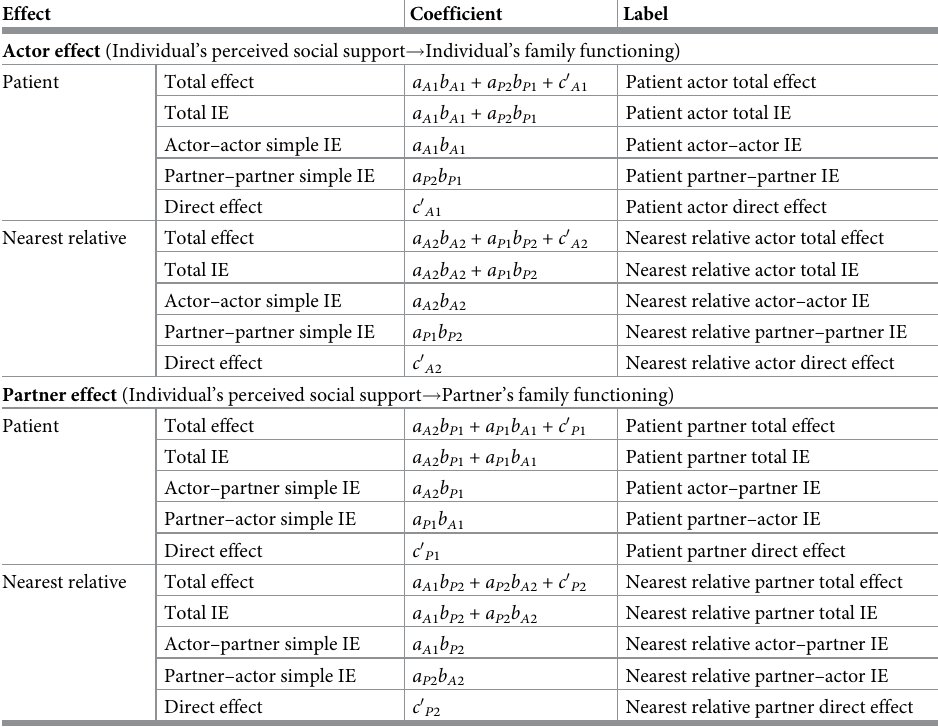
Table 2. The total effects, total indirect effects, simple indirect effects, and direct effects in the APIMeM in patients with heart failure and their nearest